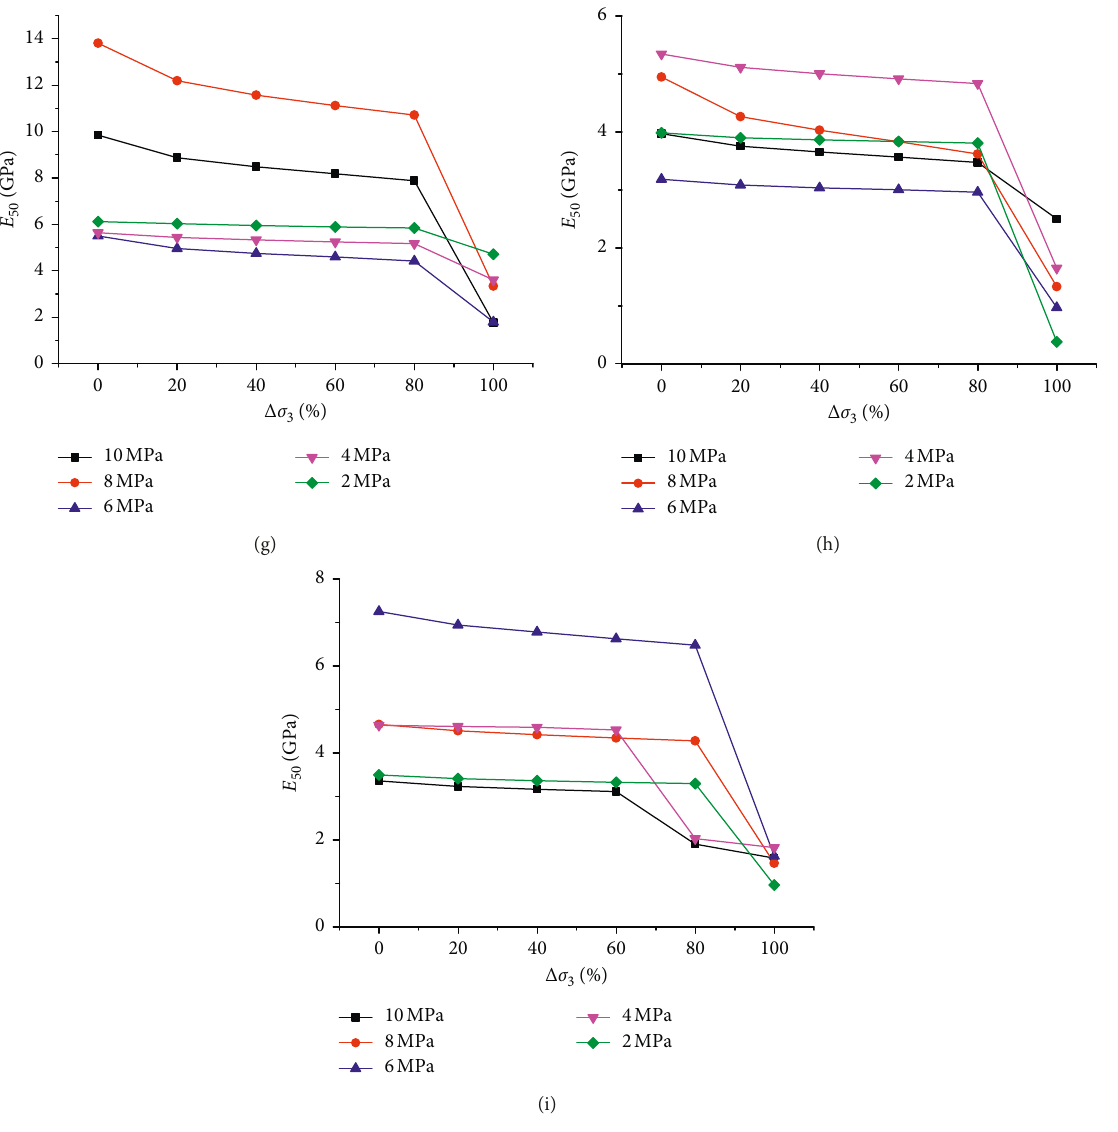
Figure 5: Relationship between deformation modulus and unloading percentage (joint orientation defined as β ; joint connectivity rate defined as k ): (a) β � 30 ° , k � 0.3; (b) β � 30 ° , k � 0.45; (c) β � 30 ° , k � 0.6; (d) β � 45 ° , k � 0.3; (e) β � 45 ° , k � 0.45; (f) β � 45 ° , k � 0.6; (g) β � 60 ° , k � 0.3; (h) β � 60 ° , k � 0.45; (i) β � 60 ° , k � 0.6.